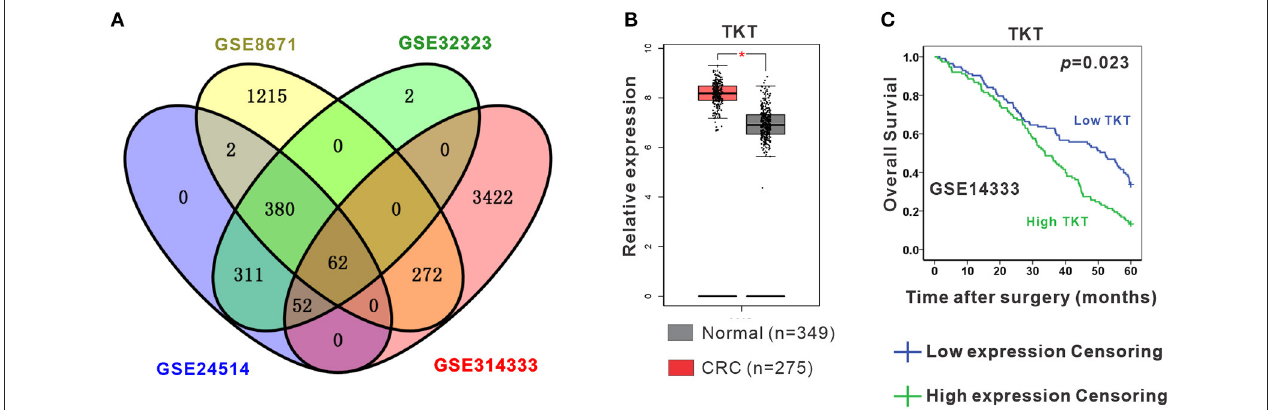
FIGURE 1 | Identification of differentially expressed genes (DEGs). (A) Four datasets (GSE8671, GSE32323, GSE24514, GSE14333) were retrieved from the GEO database to identify the shared DEGs in CRC. Eventually, a total of 62 shared DEGs were identified using GEO2R; (B) TKT was significantly and highly expressed in CRC tissues compared to normal colon tissues in the GEPIA database; (C) High TKT expression in CRC was associated with poor 5-year survival in the GEPIA database. * P < 0.05 vs. normal colon